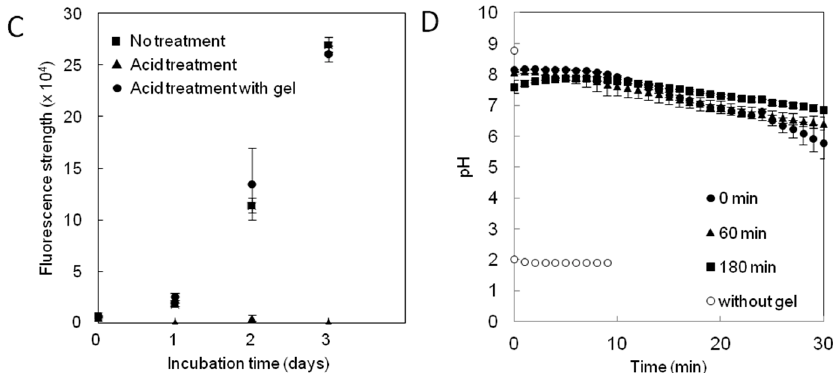
Figure 5. ( A ) Digital photographs of NIH 3T3 cells in Dulbecco’s Modified Eagle’s medium (DMEM), HCl (0.01 M), and in a gel box floating in HCl (0.01 M); ( B ) Live and dead cell assay after each treatment (red; dead, green; alive) (scale bars = 200 μ m). The encapsulated cells were collected and reseeded on tissue culture polystyrene (TCPS) dishes; ( C ) Alamar blue assay was used to assess the proliferation of the collected cells after each treatment. Data are presented as mean ± standard deviation ( n = 2 per condition); ( D ) Time-dependent pH changes of the cell suspended HCl solution without (open) and with (closed) gel box. The gel boxes were self-healed for 0 (circle), 60 (triangle), and 180 (square) min prior to UV crosslink.